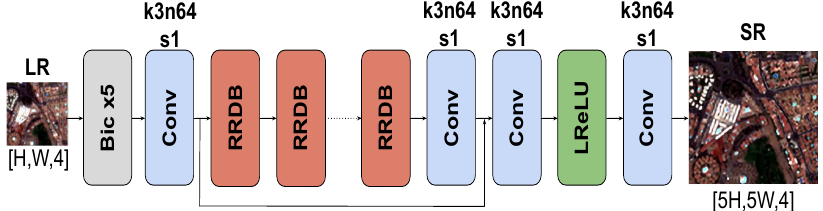
Figure 4. RS-ESRGAN Generator architecture, with a sequence of Residual in Residual Dense Blocks (RRDBs) producing the dense feature extraction of the network. Source: [7].